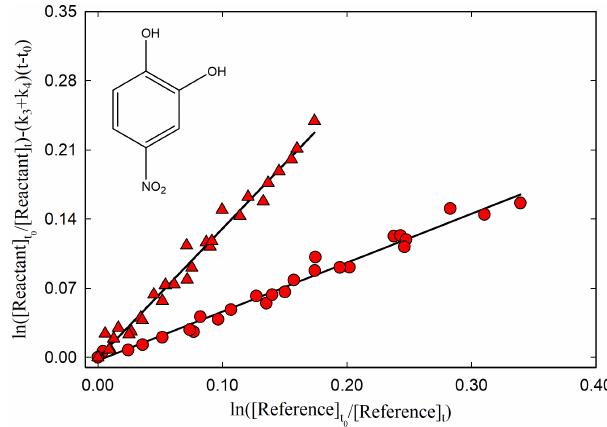
Figure 1. Kinetic plot according to Eq. (1) for the reaction of 3-nitrocatechol with OH radicals relative to dimethyl ether (red circle) and cyclohexane (red square), using photolysis of CH 3 ONO / NO mixture at 365nm as OH-radical source, with ( k 3 + k 4 ) = (4.7 ± 0.41) × 10 − 4 s − 1 .